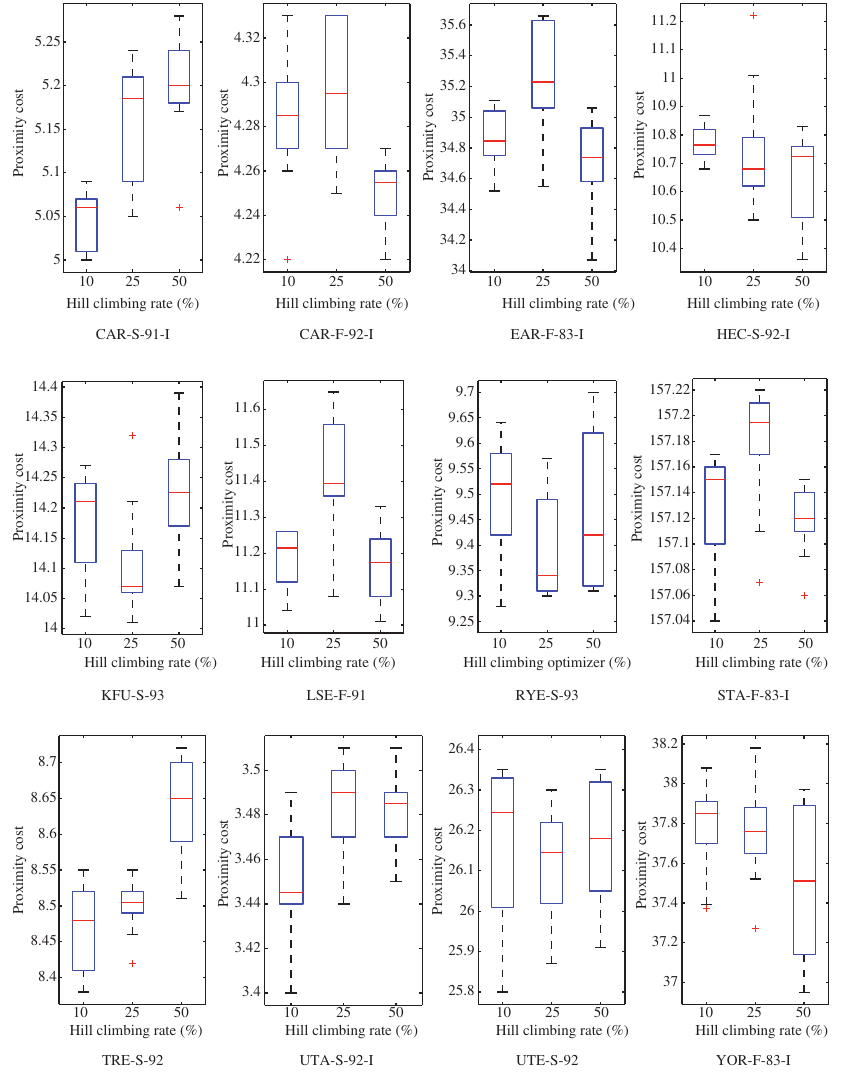
Figure 5. Boxplot Demonstrating the Effect of Varying HCR on